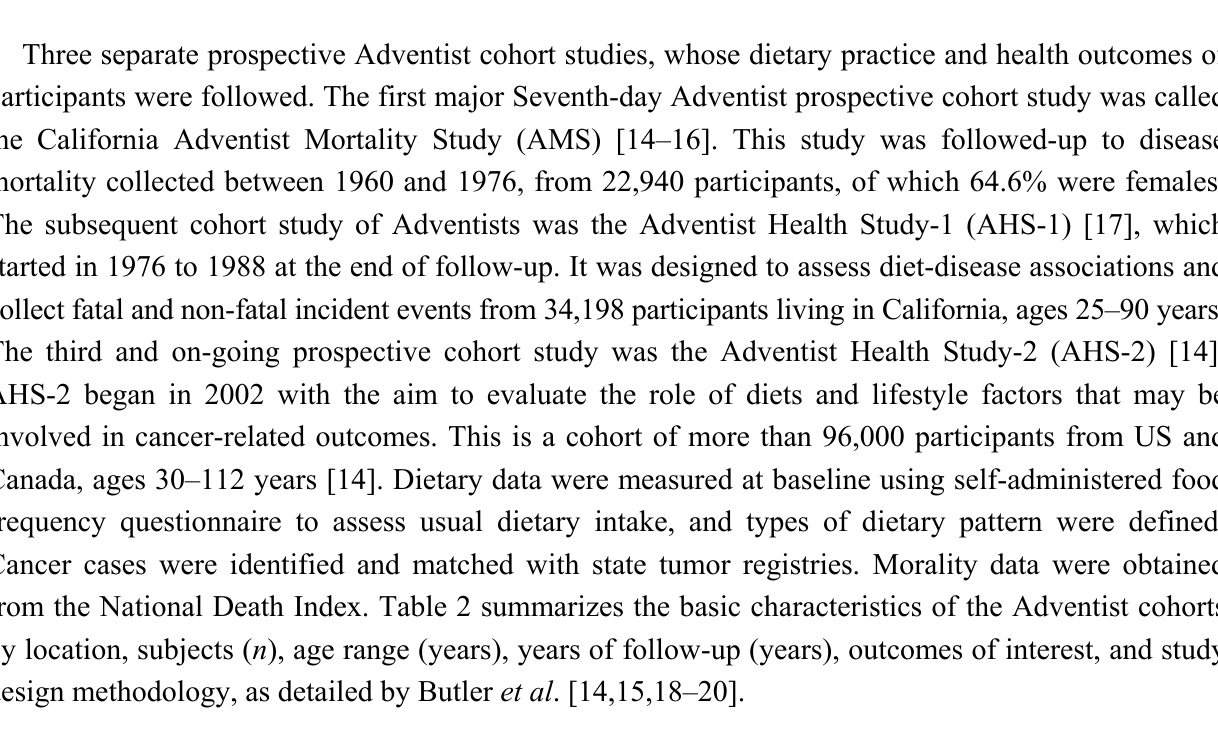
Table 2. Characteristics of Adventist Mortality Study (AMS), Adventist Health Study-1 (AHS-1), and Adventist Health Study-2